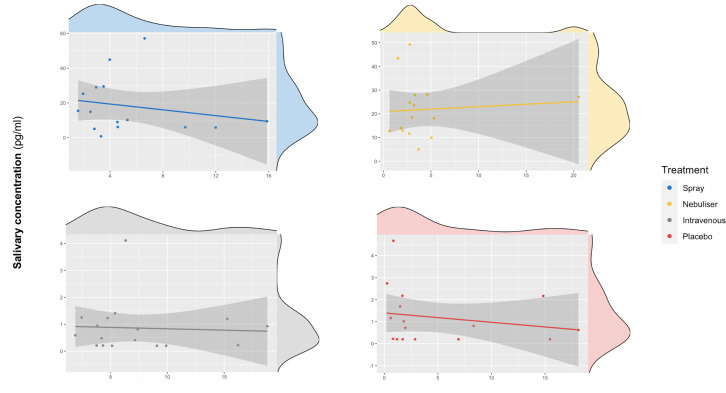
Association between salivary and plasmatic oxytocin after administration of intranasal and intravenous exogenous oxytocin.In these scatter plots, we depict the lack of association between salivary and plasmatic oxytocin concentrations at 120 and 115 min after the administration of intravenous and intranasal oxytocin or placebo, respectively. Each panel depicts data from one out of the four treatment levels. Please note that although all the statistical analyses were conducted on log-transformed oxytocin concentrations, here we plot the raw values to facilitate interpretation.